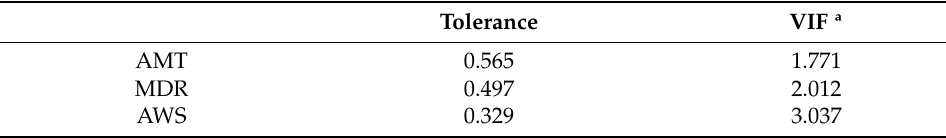
Table 5. Co-linearity analysis of spatial properties variables ( α ).